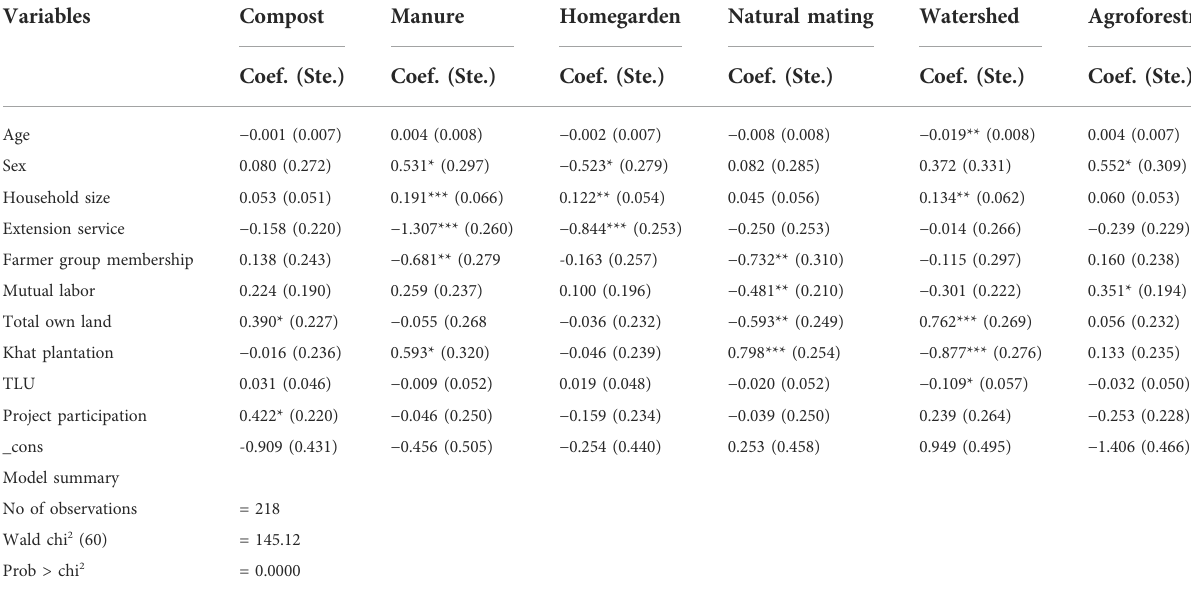
TABLE 5 Multivariate probit model results for factors in fl uencing the use or implementation of agroecological practices 1 .